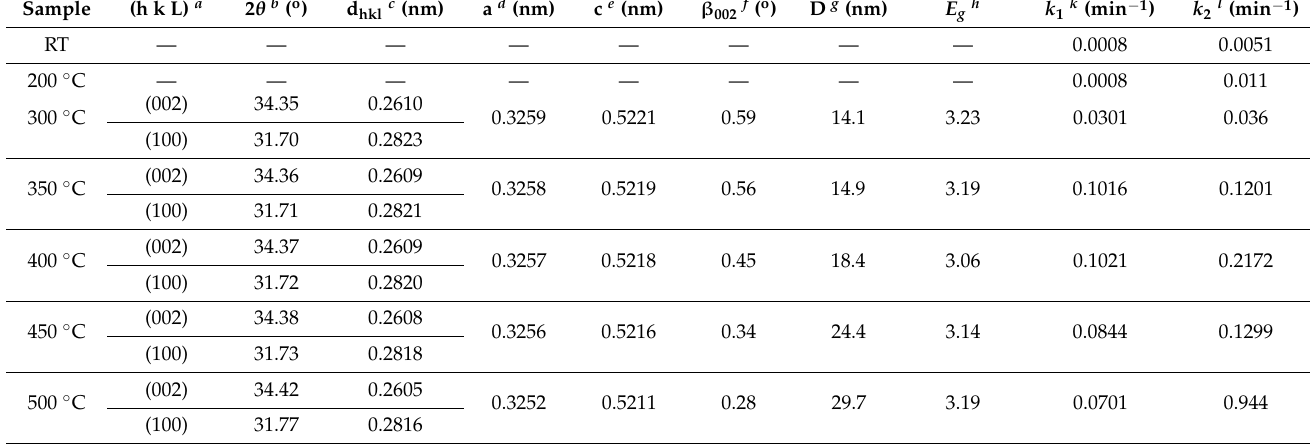
Table 1. Unit cell parameters calculated from the XRD patterns, optical band gaps, and photodegra- dation rates of the hierarchical ZnO micro-spheres prepared at different annealing temperatures.